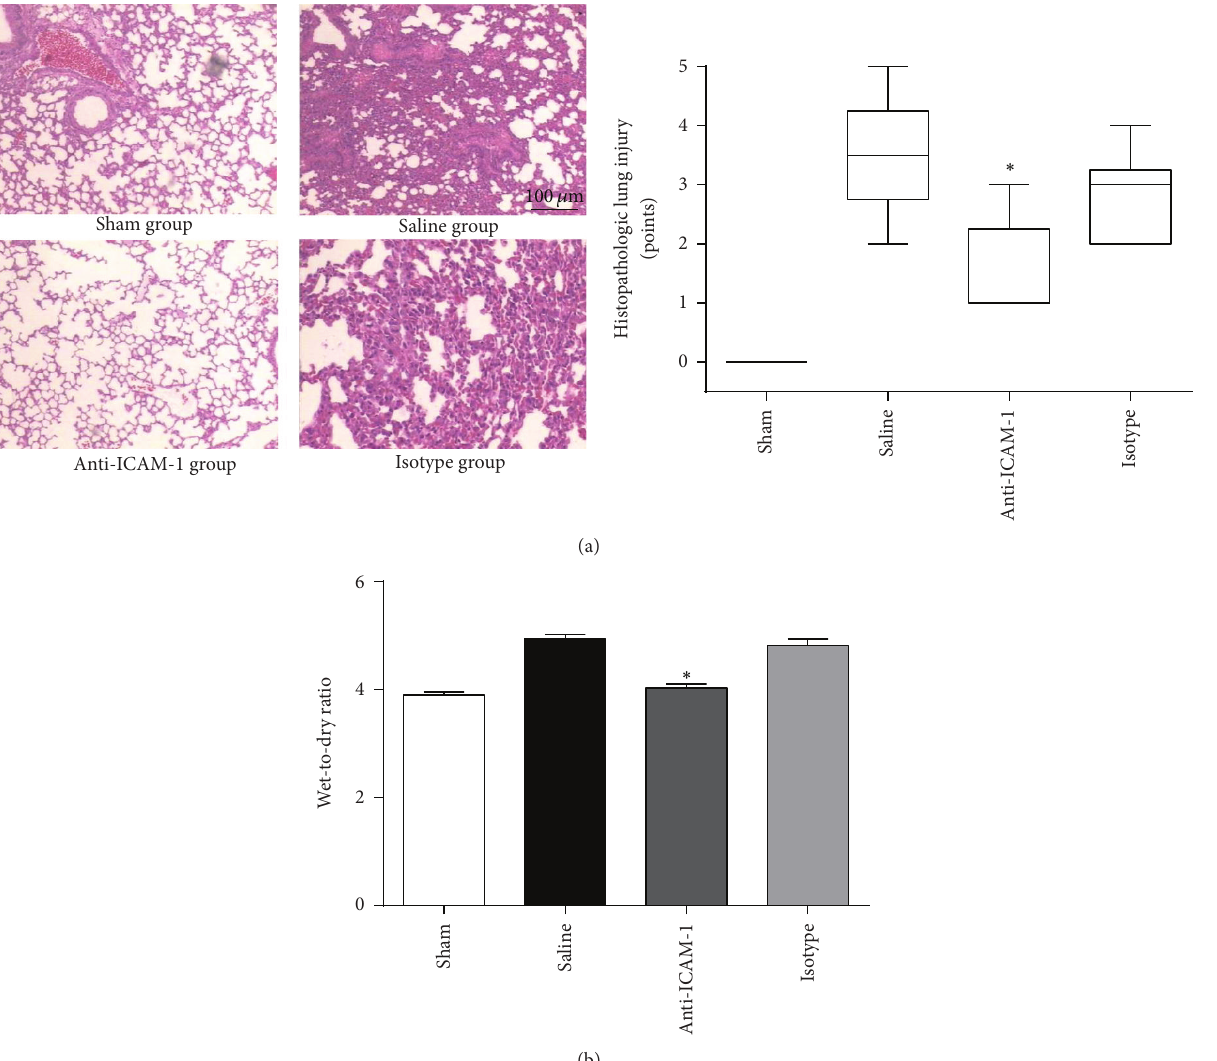
Figure 3: Anti-ICAM-1 antibody attenuated sepsis-induced lung injury as demonstrated by histopathological tests and wet-to-dry weight ratio. (a) The lungs of the anti-ICAM-1 antibody treated CLP mice, isotype antibody treated CLP mice, saline treated CLP mice, and sham- operated mice were harvested 24 h after surgery for histopathological staining. Histopathological tests showed milder impairment in lungs in anti-ICAM-1 group than in isotype and CLP groups. 𝑛 = 6 per each group. (b) Lung wet-to-dry weight ratio was reduced in anti-ICAM-1 group than in isotype and saline groups. ∗ 𝑃 < 0.05 when anti-ICAM-1 antibody treated mice were compared with mice treated with isotype antibody or saline. Bars represent the mean ±